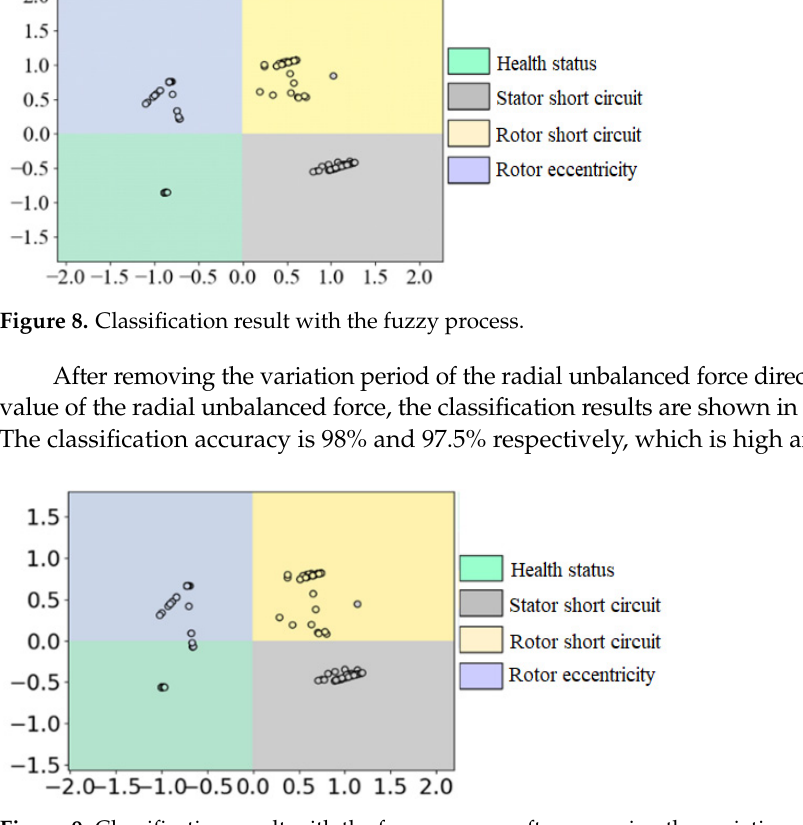
Figure 10. Classification result with the fuzzy process after removing the average unbalanced force. 4. Discussion Due to the fuzzy process on multi-source information, various feature quantities are relatively equal. For example, the temperature change of the rotor before and after the fault changed from 90 °C to 150 °C, while the rotor unbalanced force increased from 1 kN to 30 kN. There is a great difference between the change amplitude and change value, resulting in the unsatisfactory classification result of the classifier. After the fuzzy process, each characteristic signal is between 0–2, and the value range is summarized from a large number of fault data. The final classification accuracy is greatly improved and has good robustness, which means a high reliability of the fault detection system, even at a time when some of sensors do not work well.